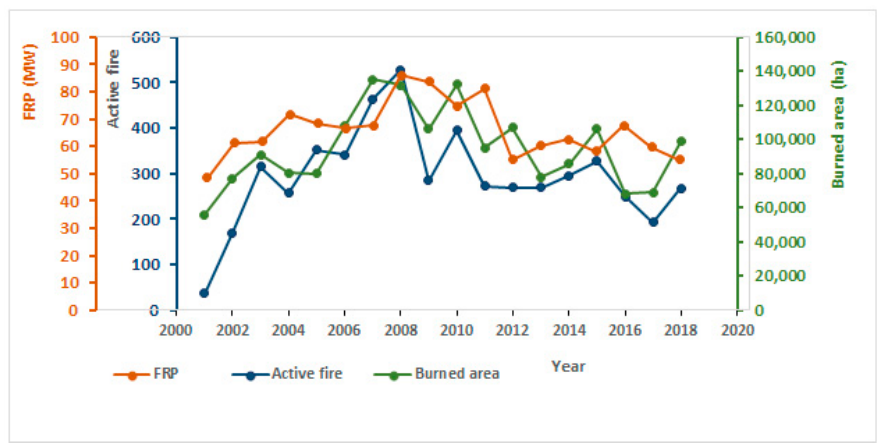
Figure 2. Spatio-temporal distribution patterns of active fires ( blue line ) showing the intensity ( red line ) and burned area ( green line ) of miombo woodlands in the study area from 2001 to 2018.